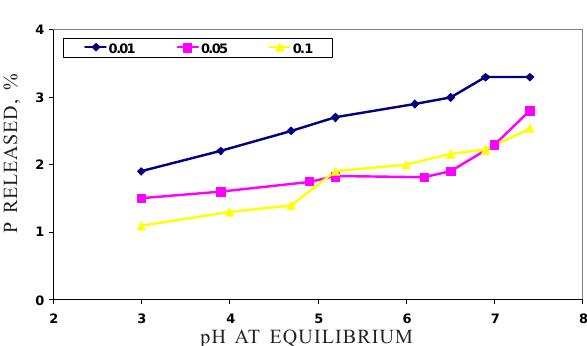
Figure 2. Scanning electron microscopy (SEM) photomicrograph of sub sample of the H8-syn (A) showing hexagonal rod crystals and of H14- syn (B) showing pseudo-hexagonal plates.